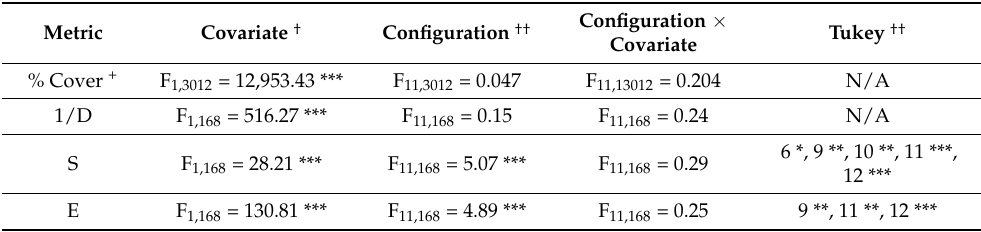
Table 2. Test statistic ( F ), significance ( p ), and degrees of freedom are reported for each factor and interaction term for linear models for four vegetation metrics: % cover, species richness (S), Simpson’s species diversity (1/D), and Simpson’s evenness (E).